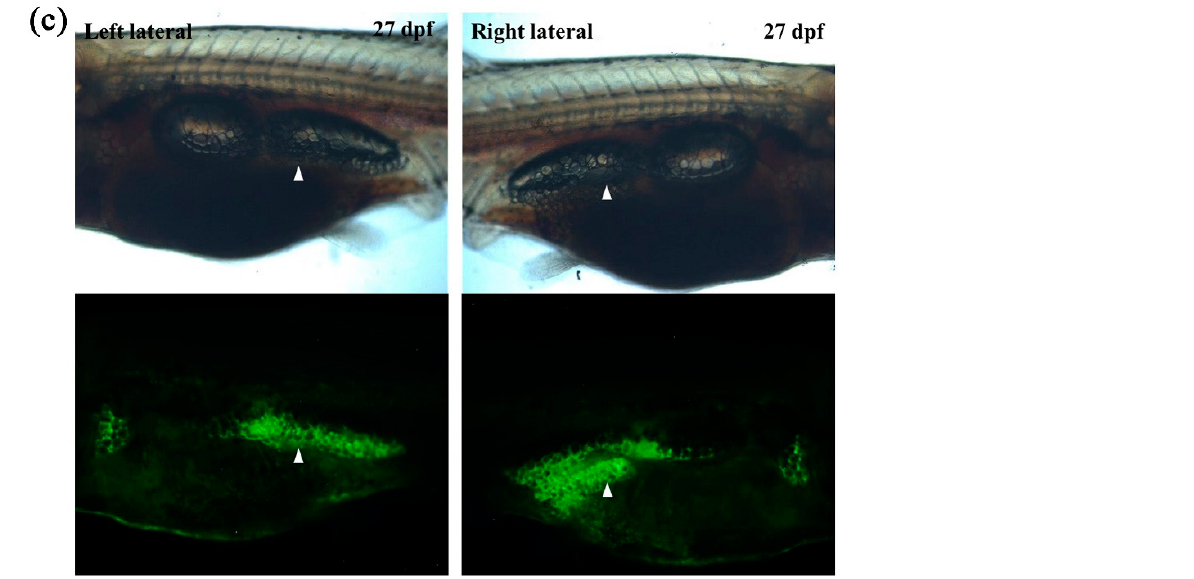
Figure 3. In vivo monitoring of visceral adipose tissue development in larvae using transgenic zebrafish. ( a ) Representative images of the first adipocyte emerging in three independent larvae at 10 dpf. ( b ) Representative images of visceral adipose tissues at 12 dpf. The first adipocyte of left lateral emerged. ( c ) Representative images of visceral adipose tissues at 27 dpf. White arrowheads indicate visceral adipose